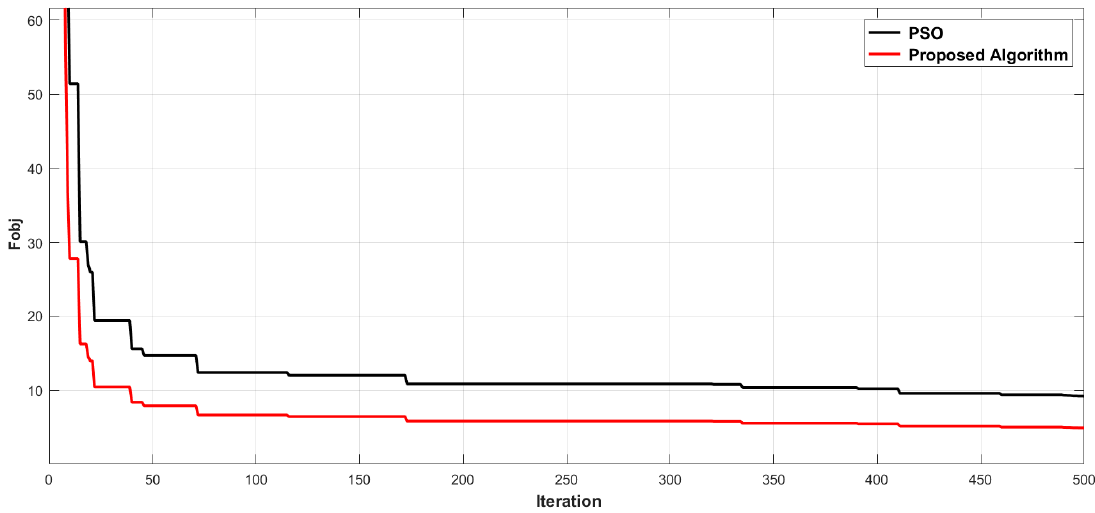
Figure 7. Comparison between the convergence profiles of the proposed algorithm and the PSO algorithm.